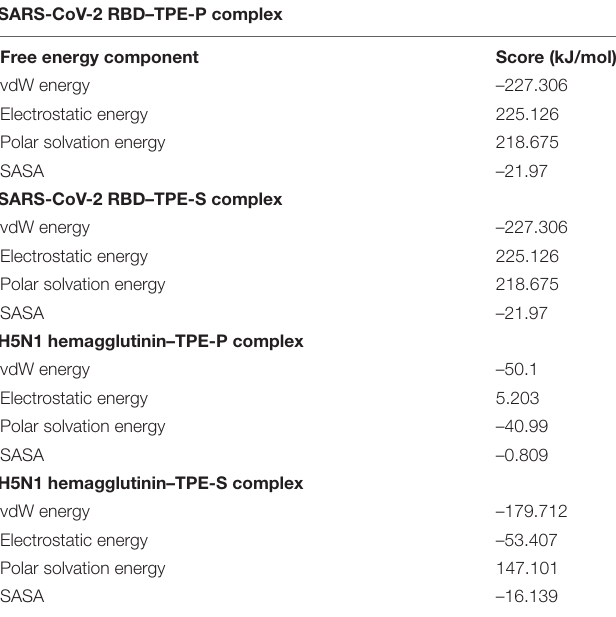
TABLE 2 | Table showing values of free energy components between TPE-P, TPE-S, and SARS-CoV-2 and H5N1 proteins. SARS-CoV-2 RBD–TPE-P